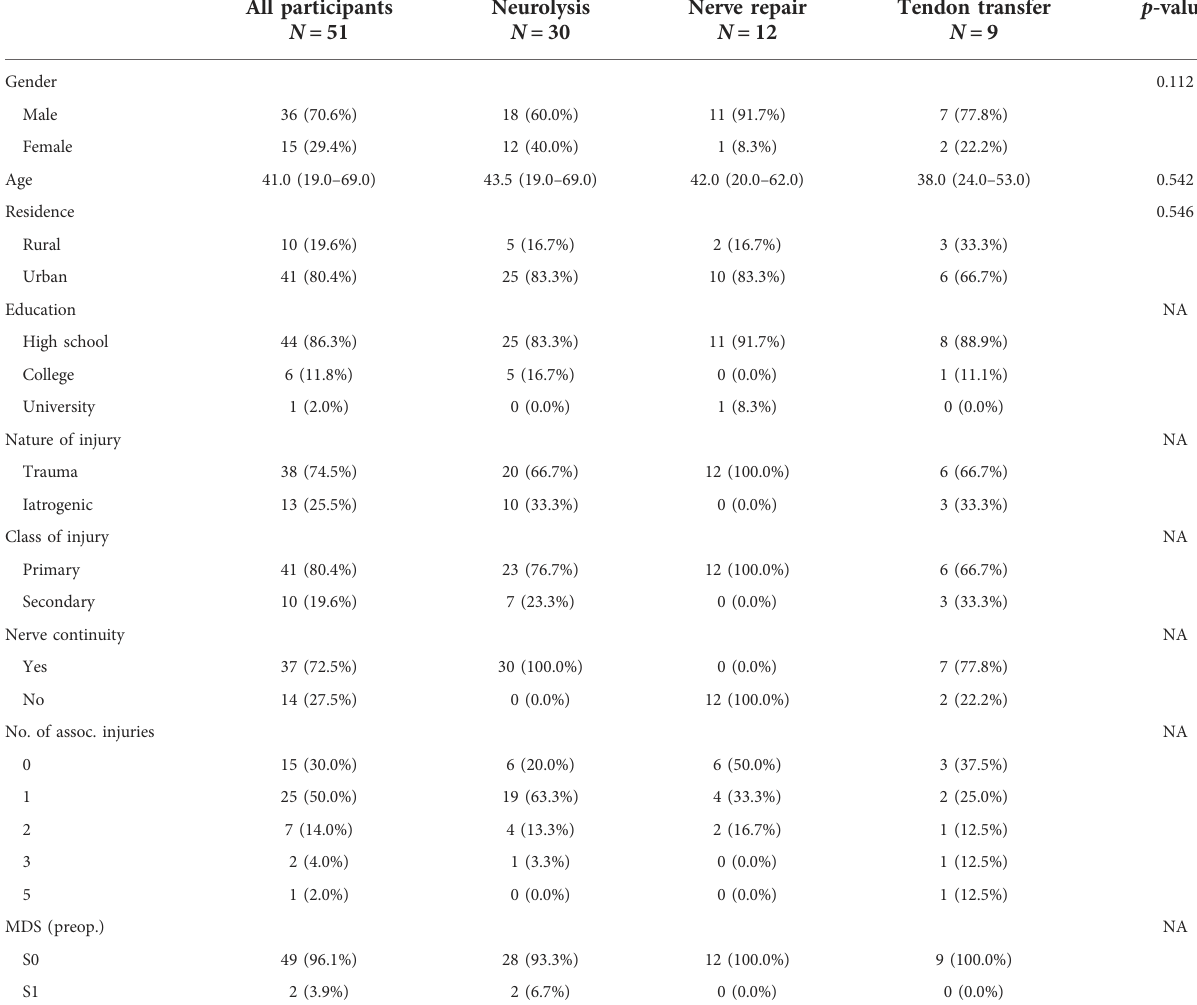
TABLE 1 Sociodemographic characteristics and preoperative status of patients by surgery class. All